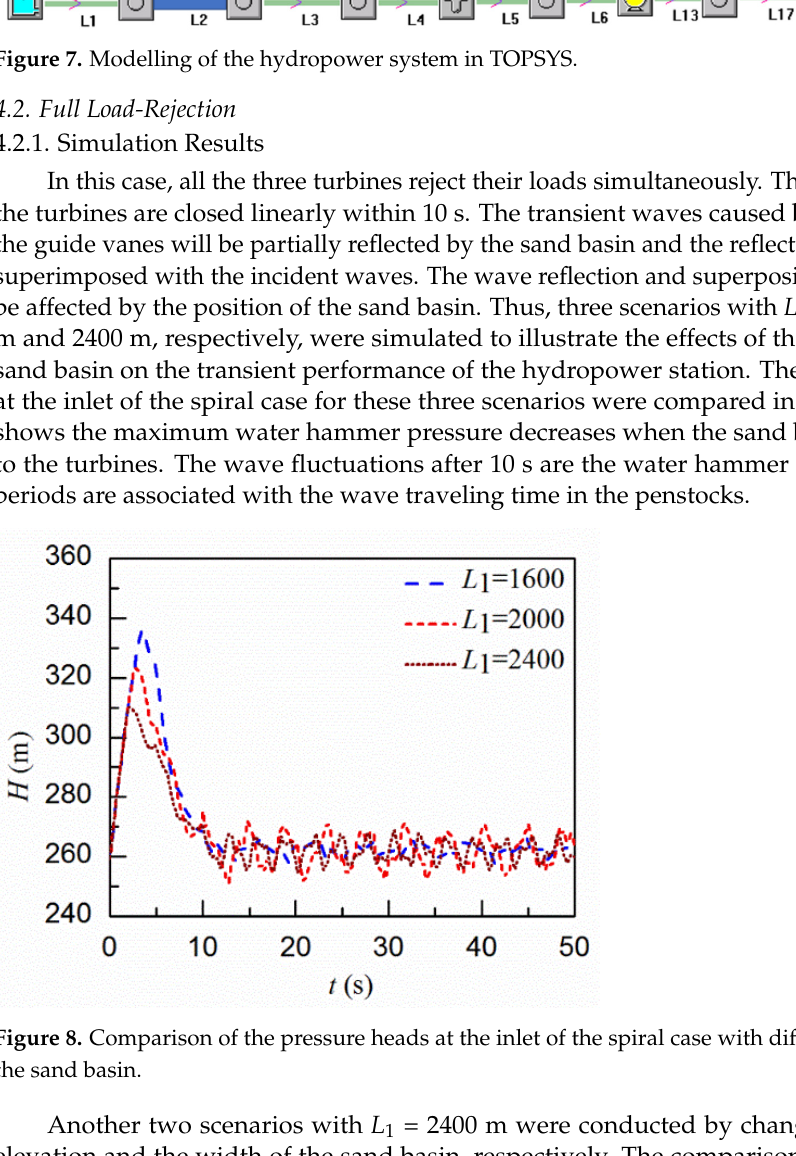
Figure 9. Comparison of the pressure heads at the inlet of the spiral case with different sizes of the sand basin.